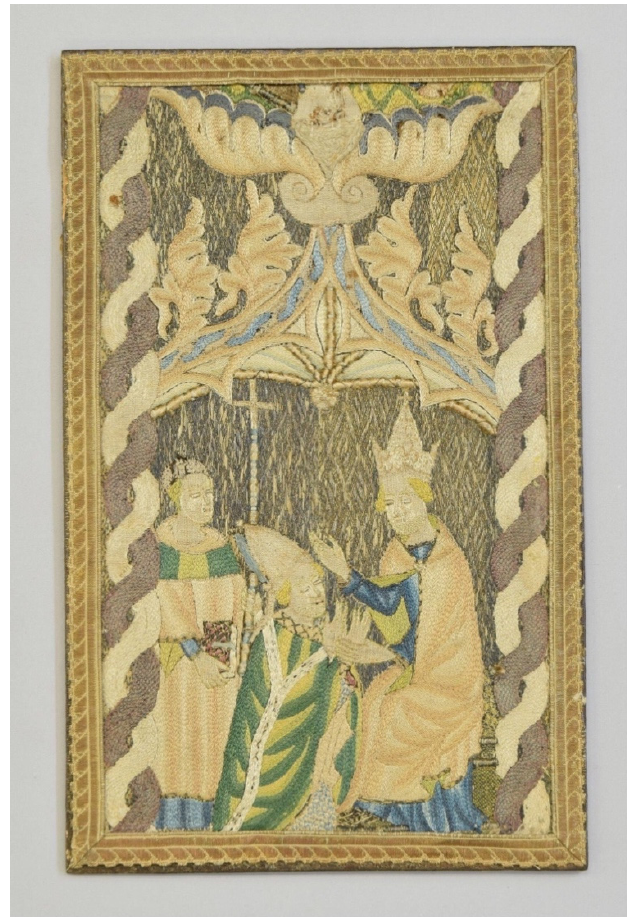
Figure 12. Fragment of orphrey, meeting between the Pope Alexander III and Thomas, ca. 1380–1410. London, Victoria and Albert Museum, England. © Victoria and Albert Museum, London.